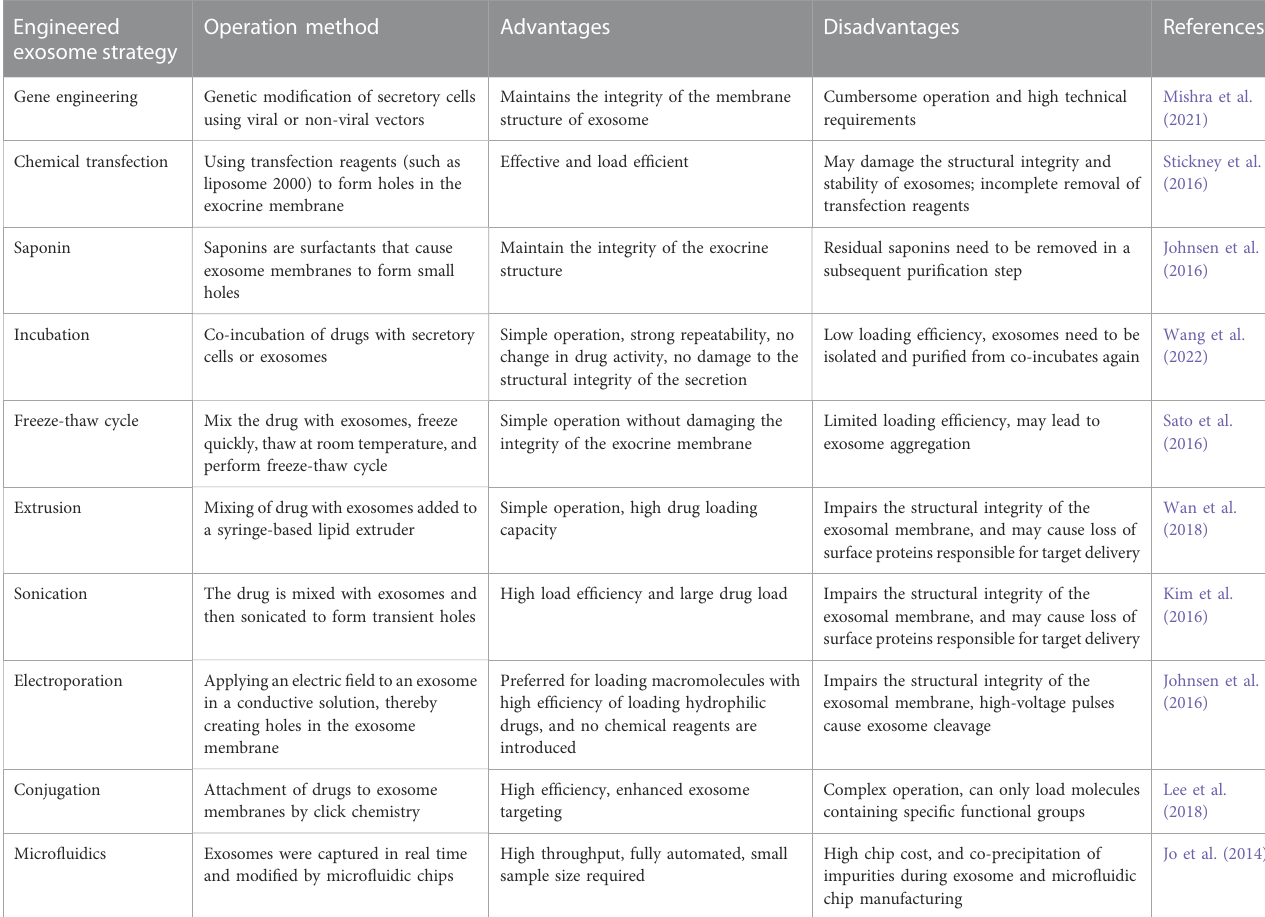
TABLE 1 Advantages and disadvantages of exosome engineering